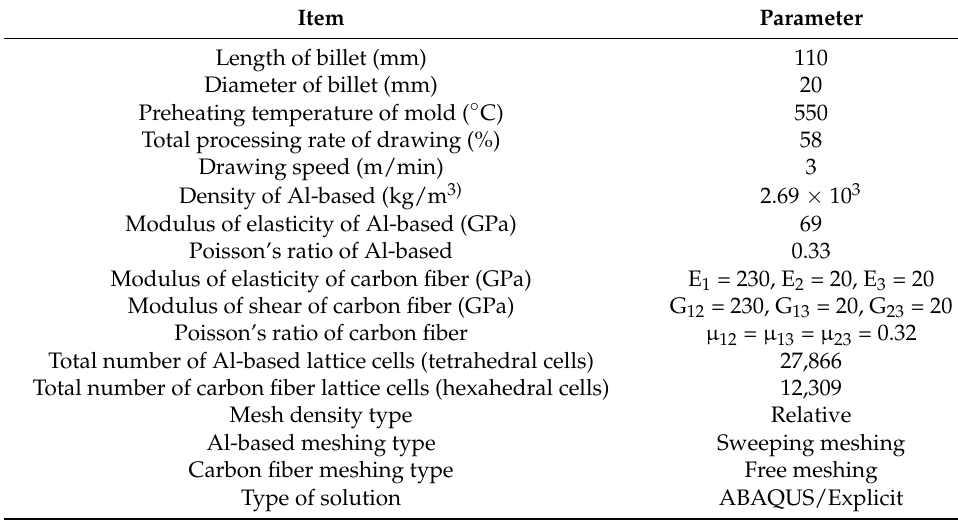
Table 3. Parameters used in numerical calculations and experiments.